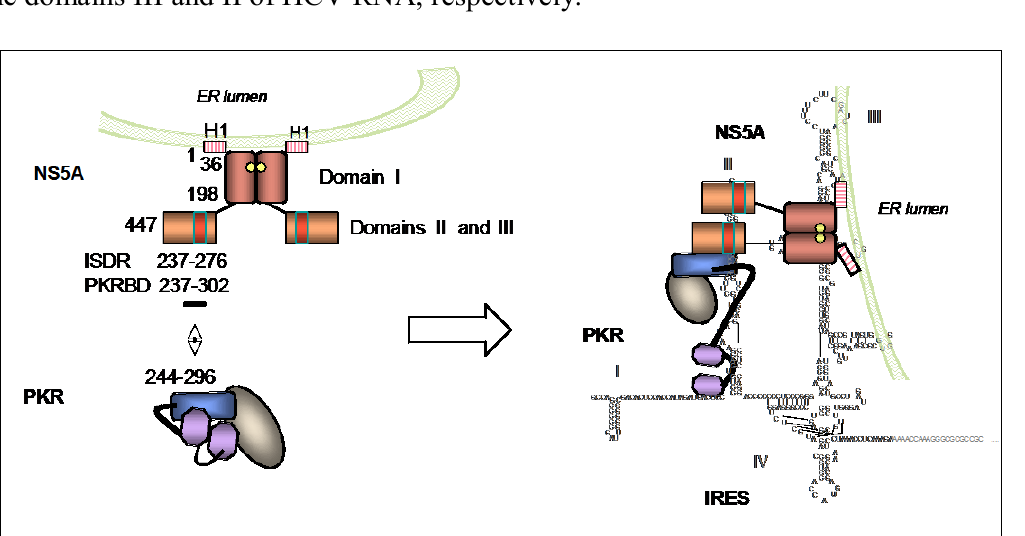
Figure 6. PKR and the HCV NS5A protein. The 447 aa NS5A protein associates as